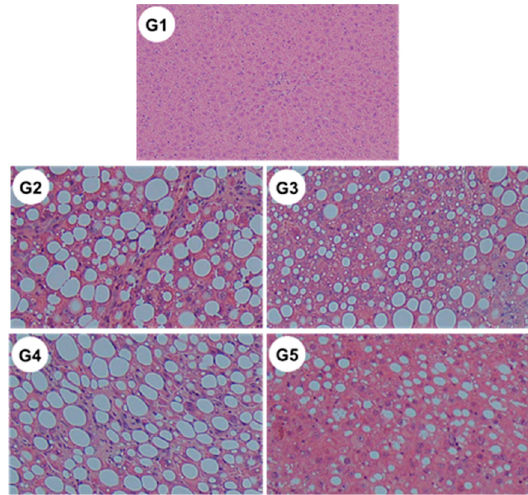
Figure 9. Effects of canagliflozin (CA) and teneligliptin (TE) on hepatic reactive oxygen species (ROS) production; ( A ) malondialdehyde ( B ) 8-hydroxy-2'-deoxyguanosine. G1, Group 1 (choline-